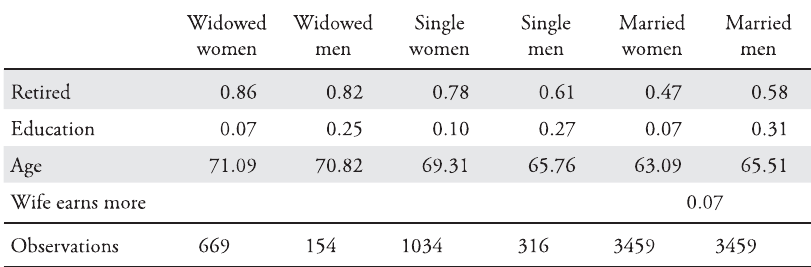
Table 1: Mean Characterilltics (x